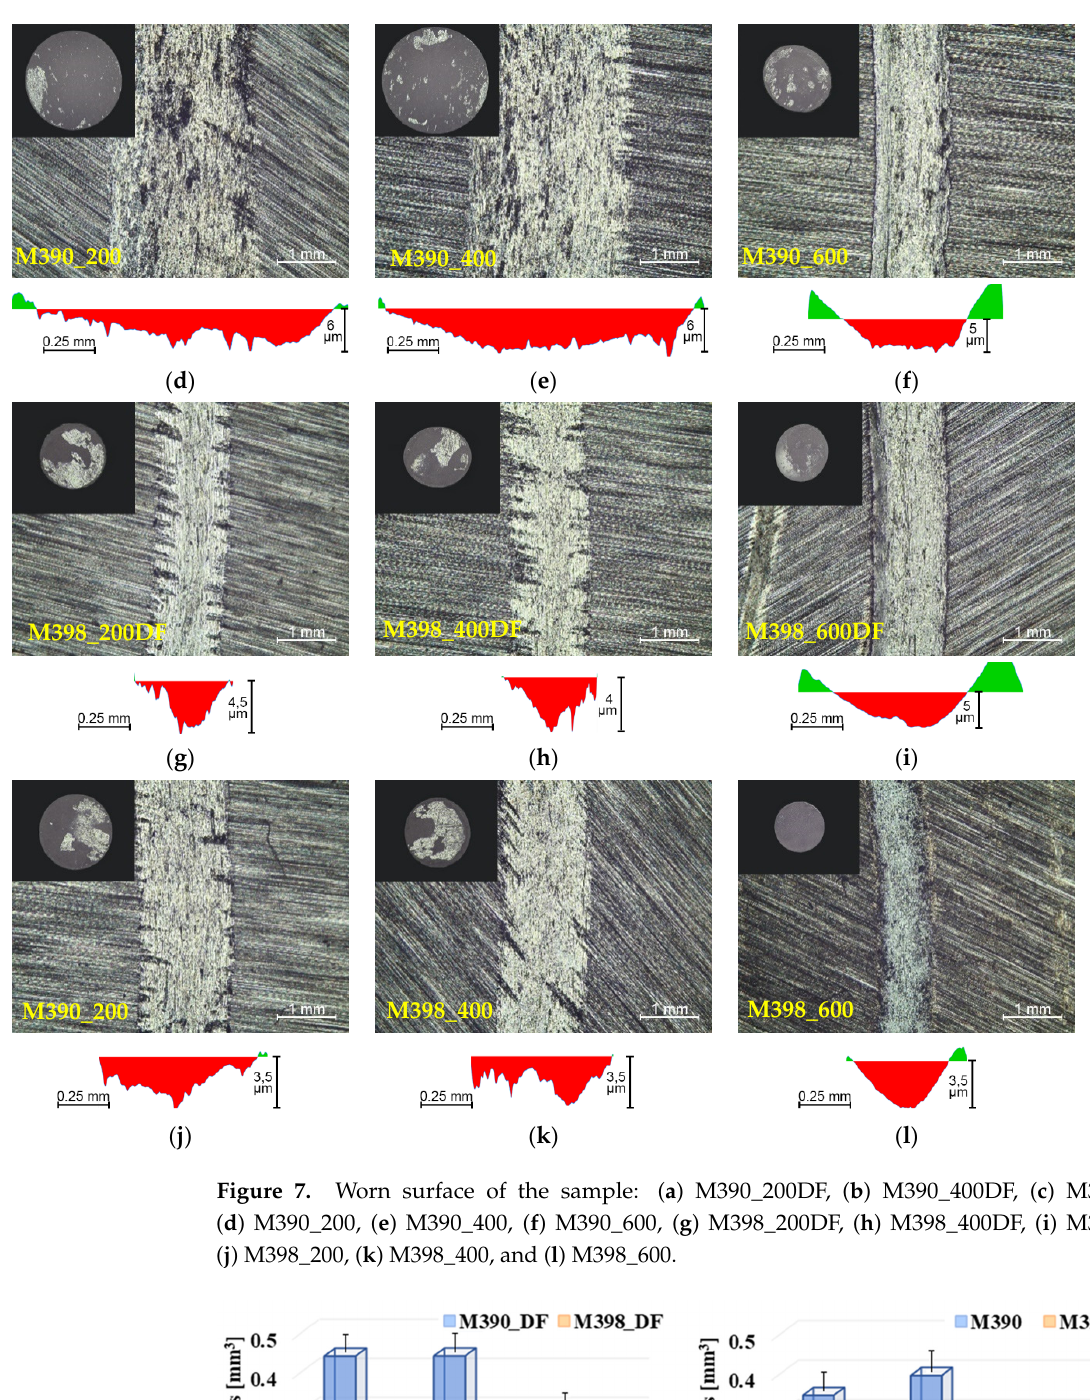
Figure 7. Worn surface of the sample: ( a ) M390_200DF, ( b ) M390_400DF, ( c ) M390_600DF, ( d ) M390_200, ( e ) M390_400, ( f ) M390_600, ( g ) M398_200DF, ( h ) M398_400DF, ( i ) M398_600DF, ( j )